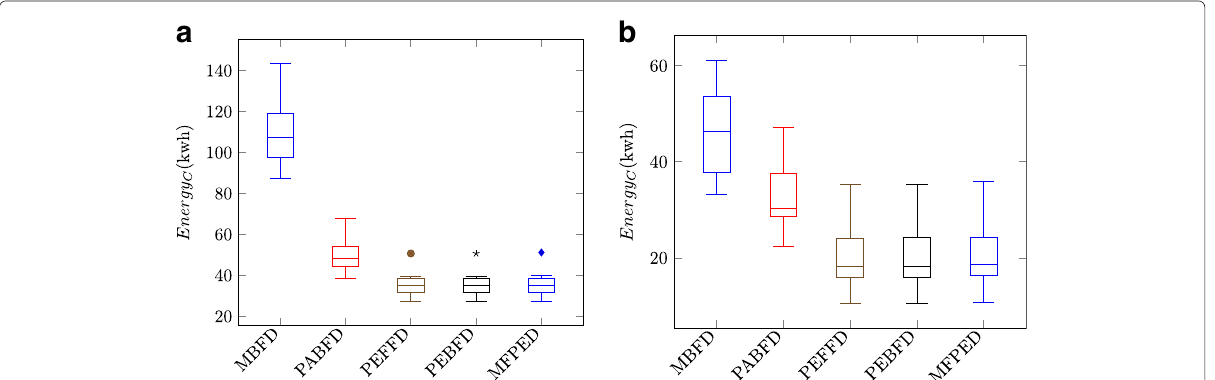
Fig. 3 Comparison by energy efficiency of algorithms in the Heterogeneous-scenario. Total energy consumption in data-center with four types of servers from dual-core HP ProLiant and quad-core IBM Xeon. MBFD and PABFD are the baseline algorithms and the rest are the proposed ones. a Results using PlanetLab traces. b Results using Bitbrains